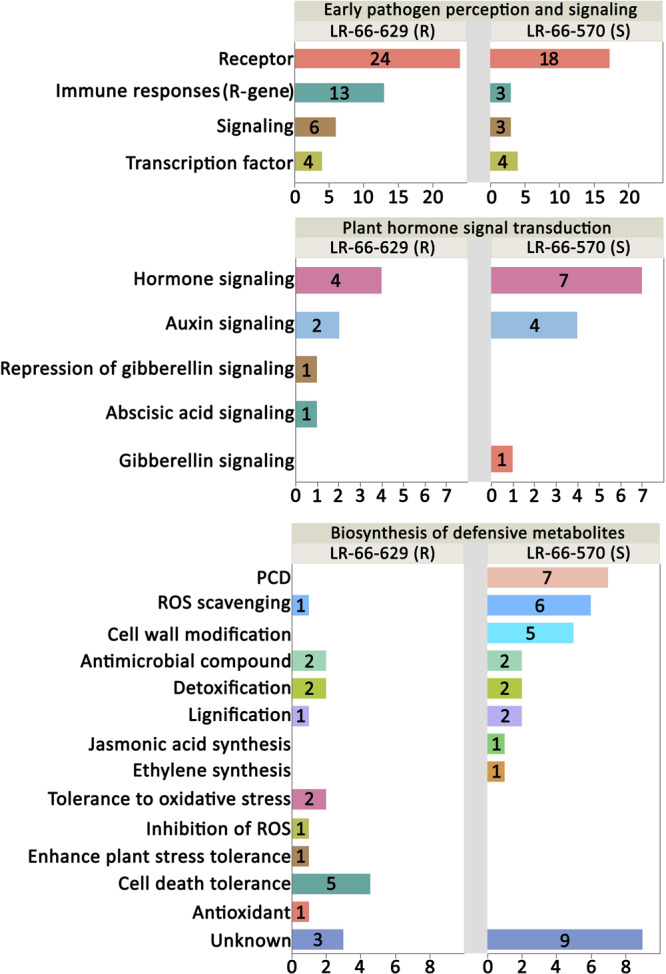
Functional analysis of putative resistance and susceptibility genes in Lens ervoides against Ascochyta lentis. Putative resistance and susceptibility genes were searched against the published literatures to understand their functions in plant disease defense system. The vertical axis indicates the functional category and the horizontal axis represents the number of genes per category.